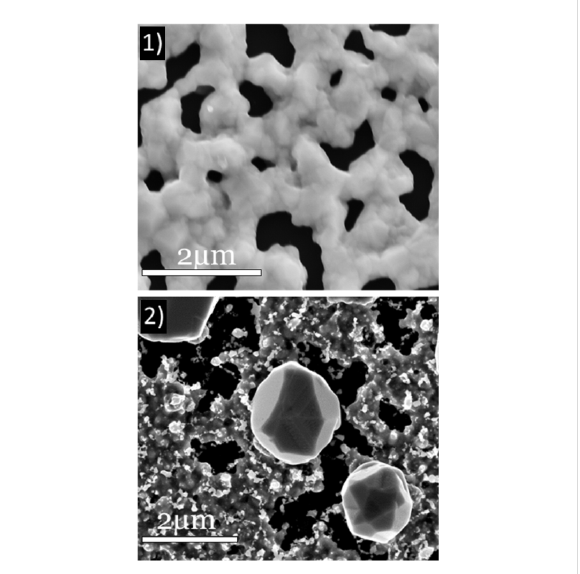
Figure 5: SEM plan-view image obtained after annealing a 340 nm thick Ge layer sputtered on the native Si oxide of a Si(001) substrate: (1) without implantation and TB = 0.64 µm; and (2) with Se implanta- tion and TB = 8.7